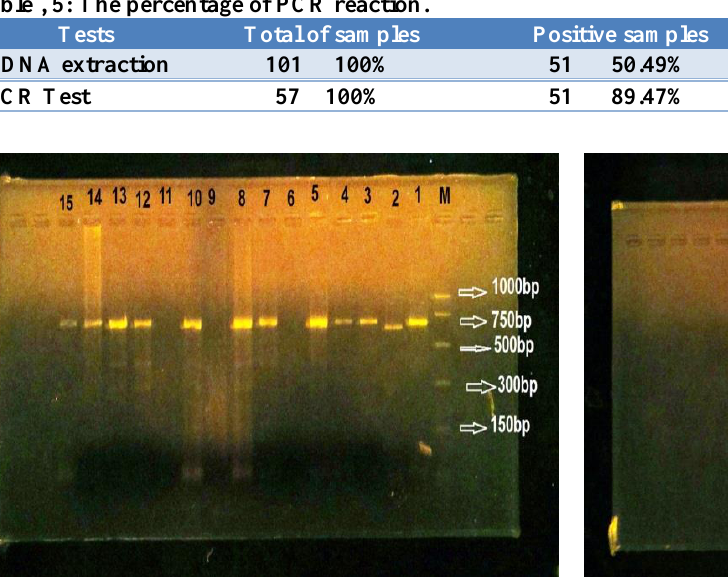
Figure, 1: Show typical PCR product of S. equi subsp. equi. with size of 677 bp using the SeM lane 1,2,3,4,5,7,8,10,12,13,14,15. Negative reactions of S. equi with primers of SeM lanes 6,9,11. Lane M , 100bp ladder served as size marker.